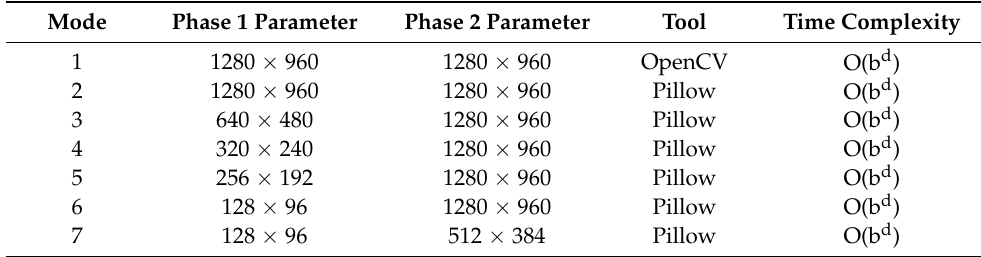
Table 6. Parameter Table 6. Parameter combination.